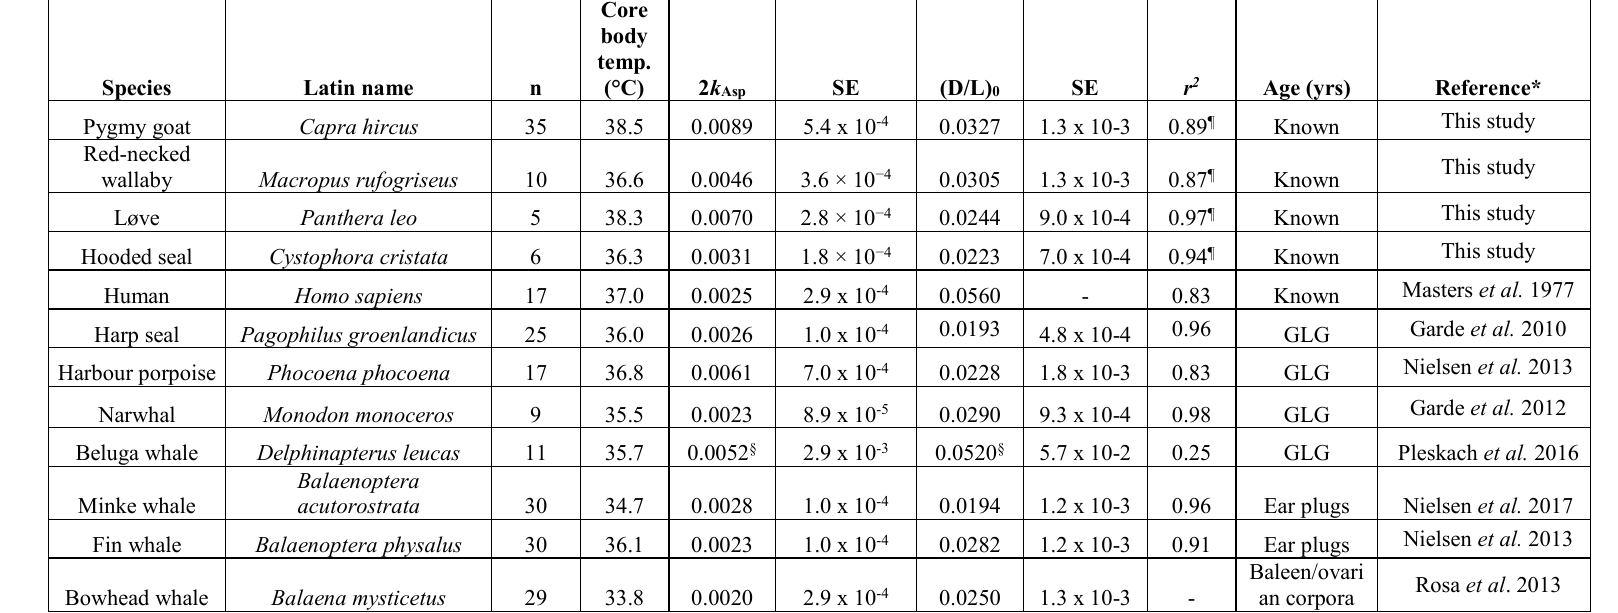
Species Latin name n